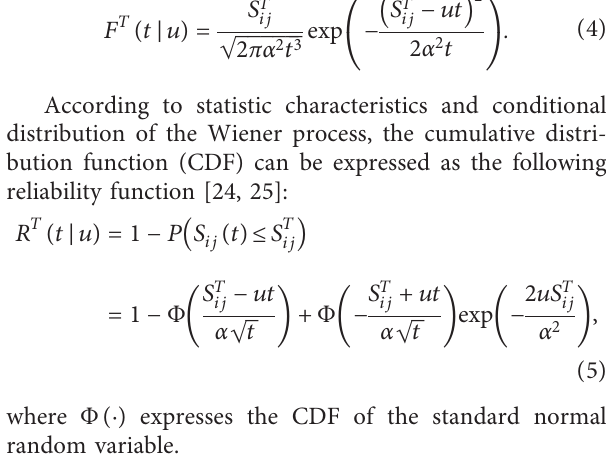
Figure 1: D2D collaborative video transmission